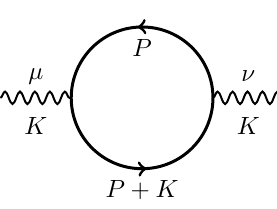
Figure 2 . Vacuum polarization diagram. Since the background electric field is classical, this is the only diagram contributing to the susceptibility. The solid lines denote the finite temperature fermion